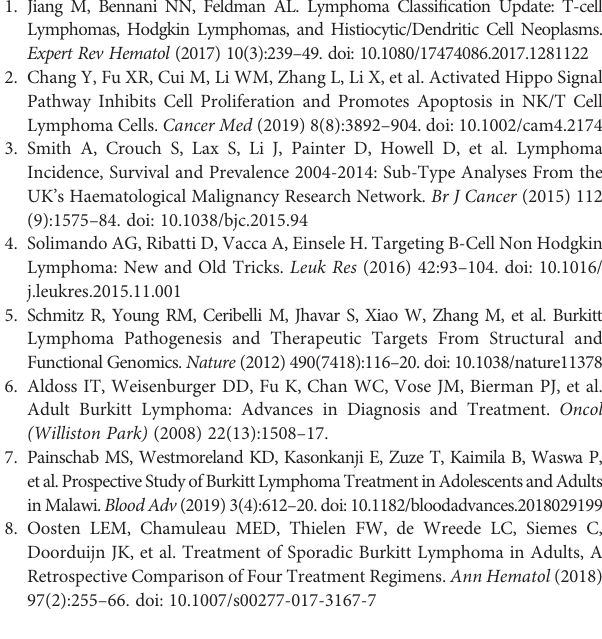
Supplementary Figure 2 | Combination of curcumin with HHT inhibited VEGF secretion by Raji cells via inactivation of the transcription factors STAT3 and SP1. Raji cells were treated with 5 ng/mL HHT or/and 10 m M curcumin for 72 h or treated with HHT, curcumin and VEGF. (A, B) Expression levels of p-STAT3, STAT3 and SP1 in Raji cells were detected with western blotting. The relative expressions of p- STAT3andSP1incellswerequanti fi ed via normalizationtoSTST3and b -actin. * P<